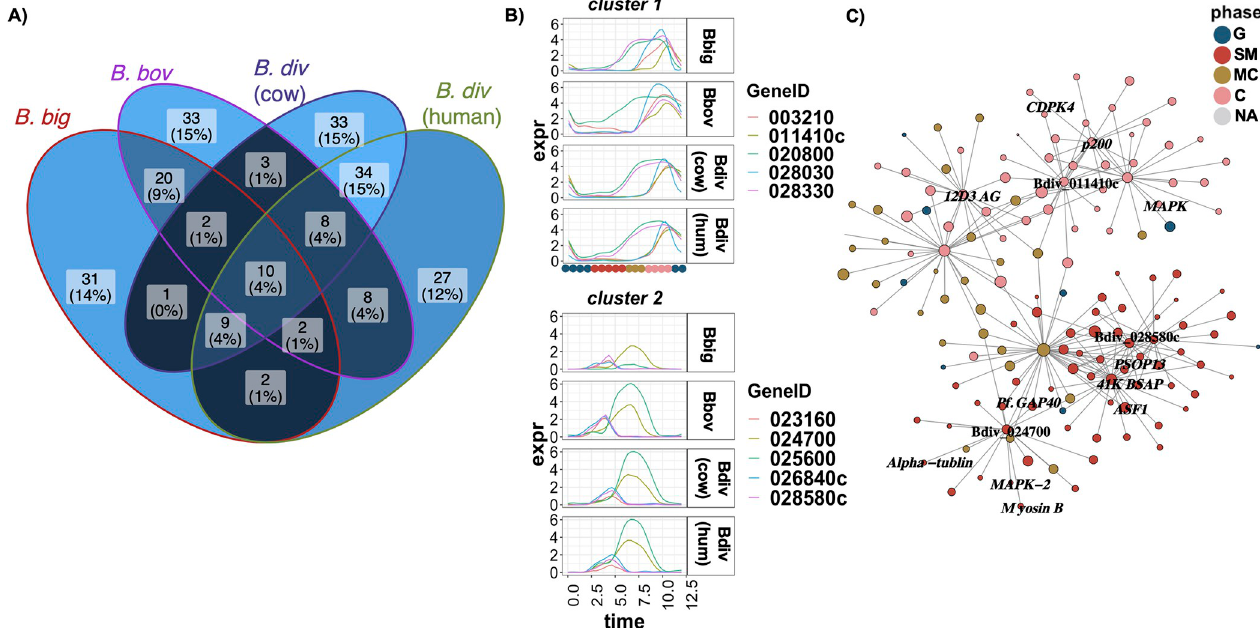
Fig 7. Co-expression network. (A) Figure showing the number of overlapping genes in the indicated contrast. (B) The expression curves of the 10 conserved hub genes at the intersection grouped into 2 clusters with similar expression profile. (C) The inferred interactome of 10 conserved hub genes in the B . divergens (human) co-expression network. NA, not available. AU : PleasecheckthatnotavailableisthecorrectdefinitionofNAinthefigurelegendforFig 7 : Ifnot ; pleaseeditasnecessary : Data and code for generating the figure are available at https://github.com/umbibio/scBabesiaAtlases.